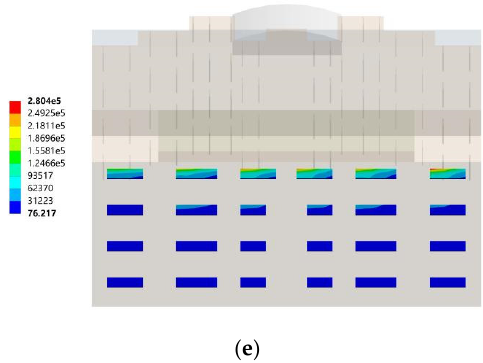
Figure 10. The southeast wind, where the southward horizontal sun visor changed with the orien- tation of the building. ( a ) Cloud map of sun visors in the south direction; ( b ) Cloud map of the sun visors in the direction of south by west 15; ( c ) Cloud map of sun visors in the direction of south by west 30; ( d ) Cloud map of the sun visors in the direction of south by east 15; ( e ) Cloud map of the sun visors in the direction of south by east 30.